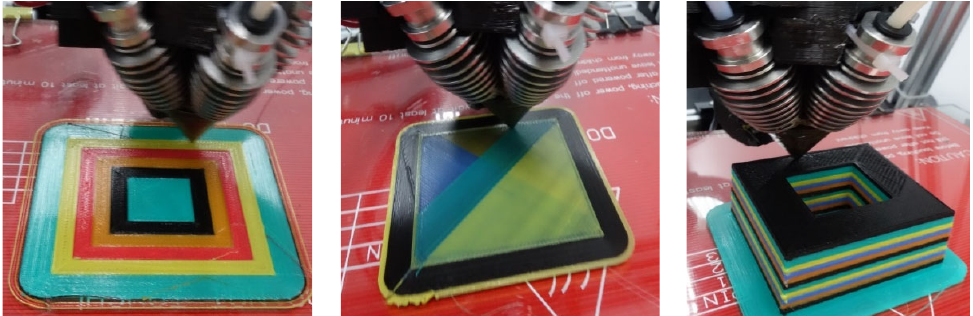
Figure 7. Printing objects with multiple colors.